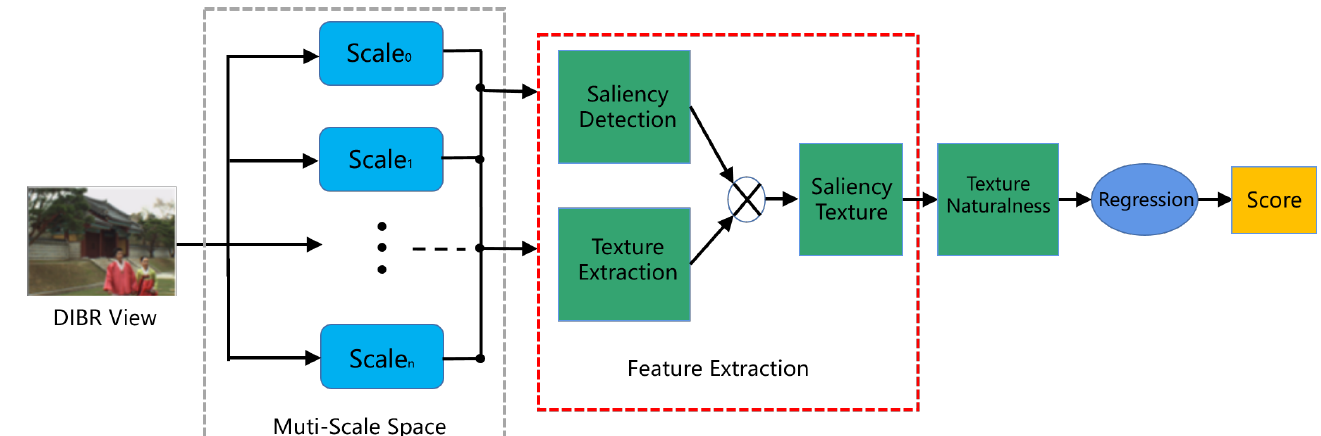
Figure 2. The flowchart of our proposed measurement